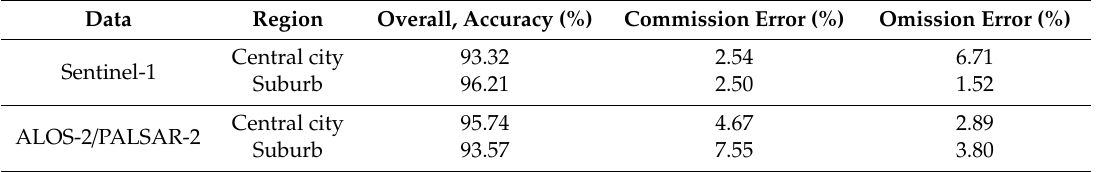
Table 8. Accuracy evaluation of the extraction results based on Sentinel-1 and ALOS-2 SAR